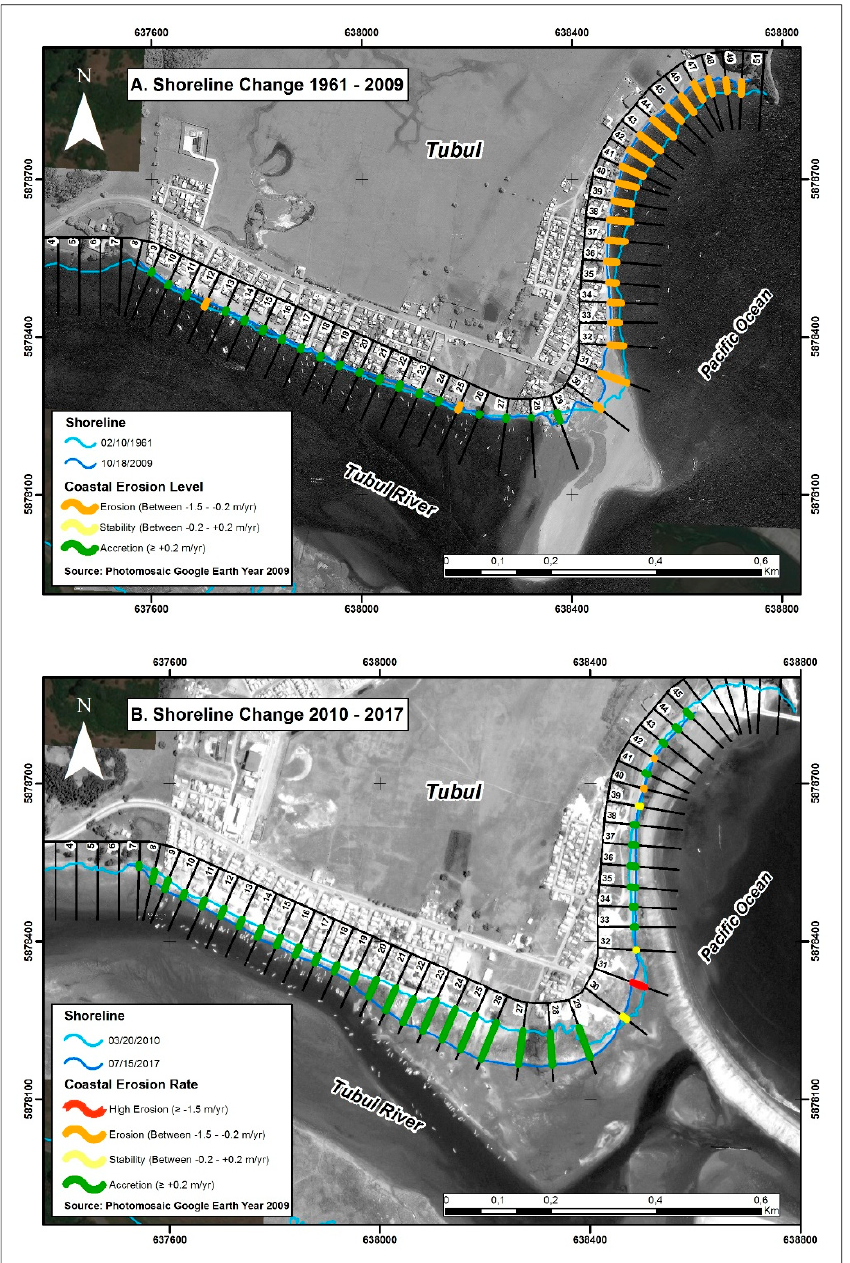
Figure 5. The shoreline changes in two time periods are presented: ( A ) shows shoreline evolution between 1961–2009; ( B ) shows shoreline evolution between 2010–2017. Green lines indicate accre- tion, yellow lines indicate stability, orange lines indicate moderate erosion, and red lines indicate strong erosion.